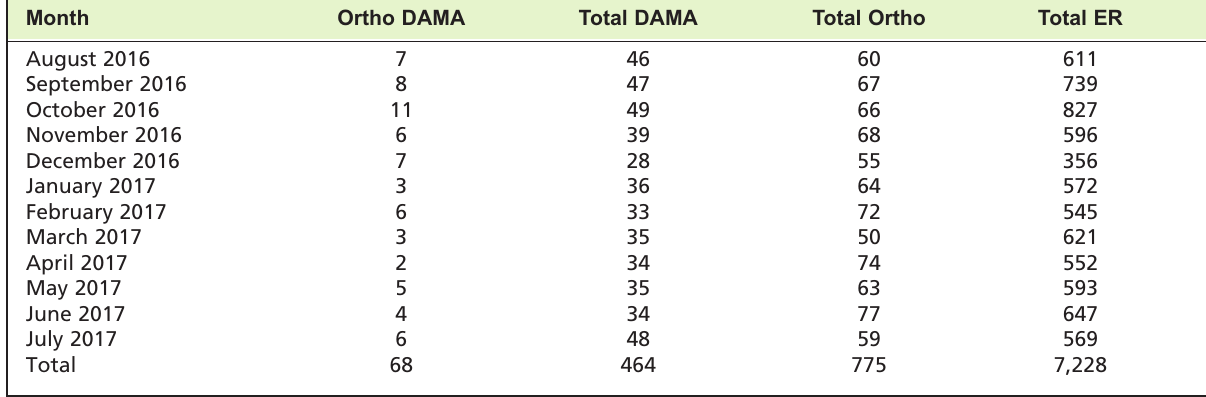
Monthly figures for Orthopaedic and overall walkouts from the Emergency Room Table II: